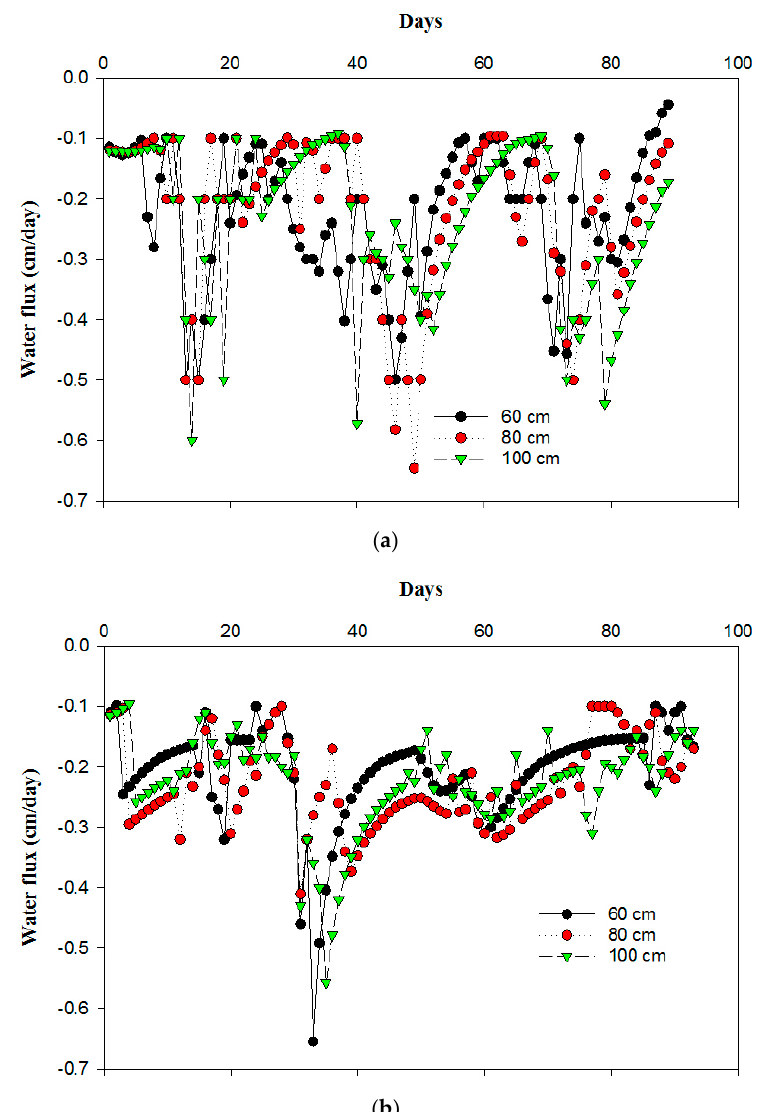
Figure 8. Simulated water fluxes below root zone (60–100 cm) during the ( a ) off-season and ( b ) main season.